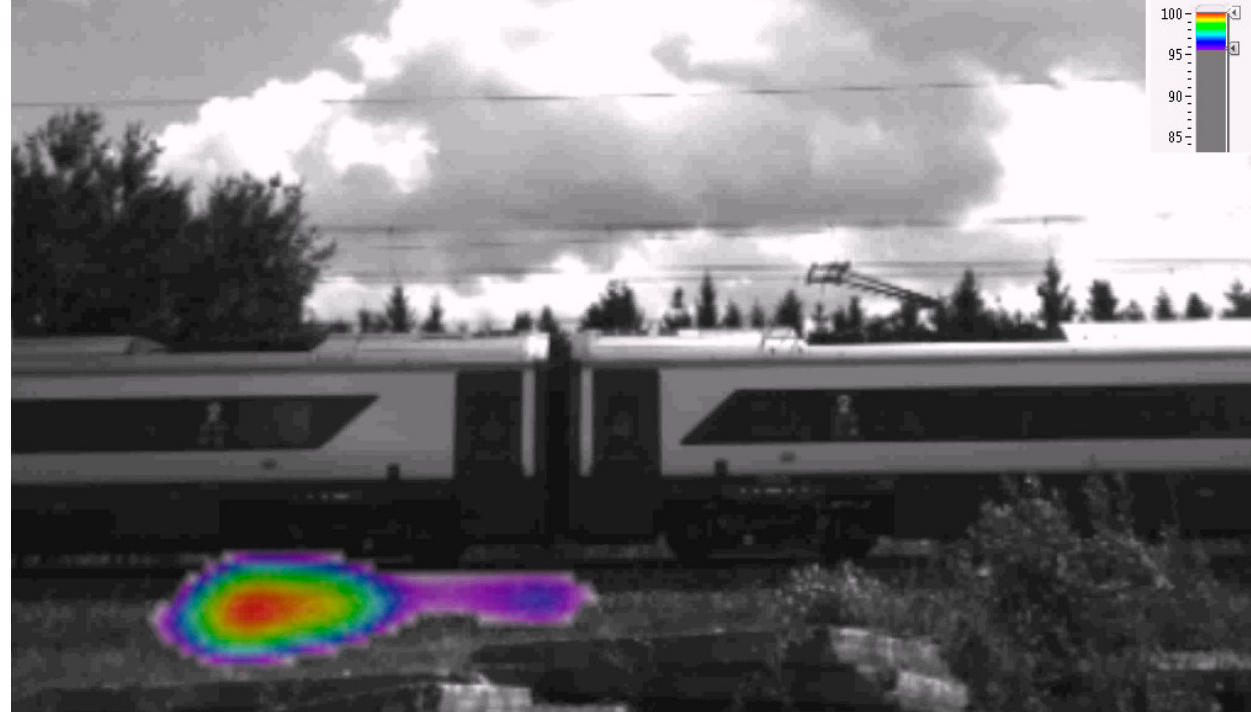
Figure 11. Sound level distribution within a frequency range of 1000–2000 Hz—straight section.